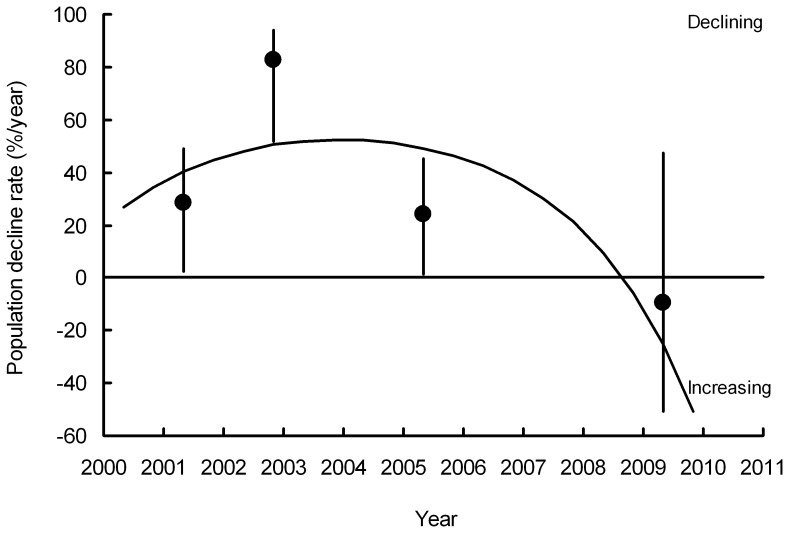
The rate of population decline (% per year) of Gyps bengalensis in India.Circles show average annual rates between each pair of consecutive surveys with their 95% bootstrap confidence limits (vertical lines) plotted midway between the dates of the two surveys. The curve shows the first derivative of the cubic log-linear population trend fitted to the survey data for the period 2000–2011.